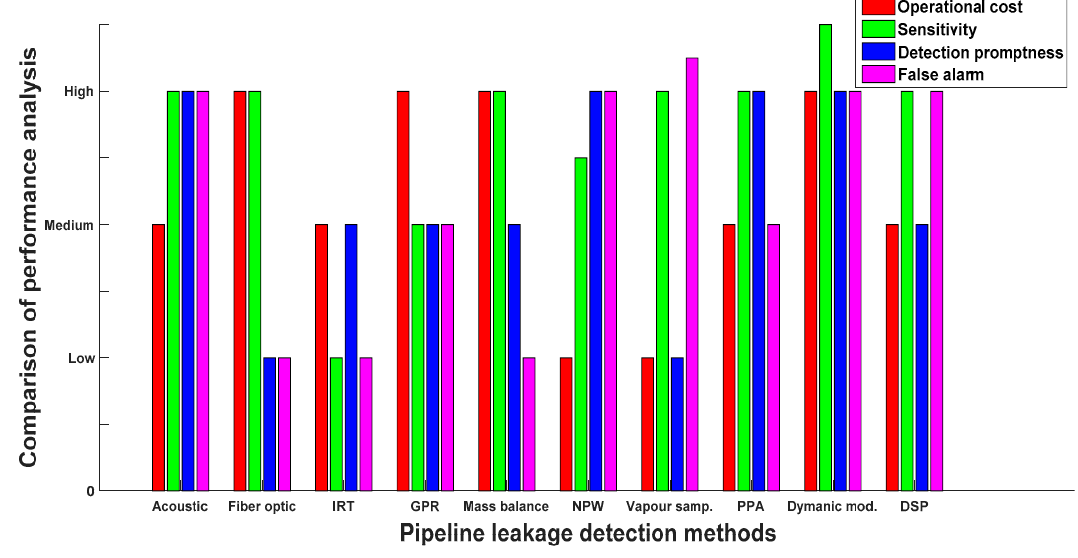
Figure 10. Three level performance analysis comparison.